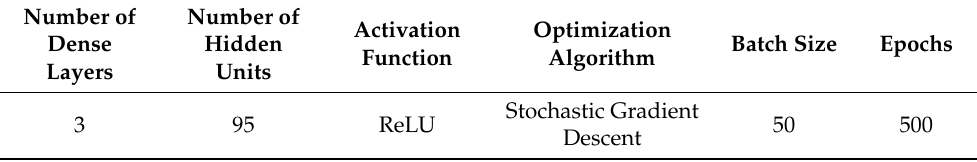
Table 5. Model Architecture for Deep Learning Regression in Knime.